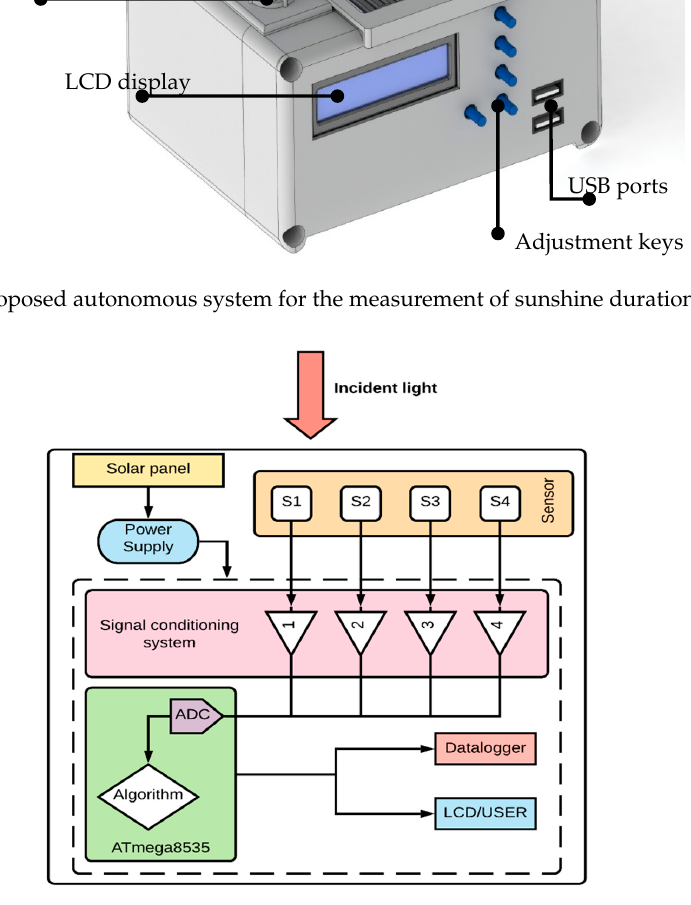
Figure 2. Diagram of the proposed sunshine duration (SD) monitoring system.